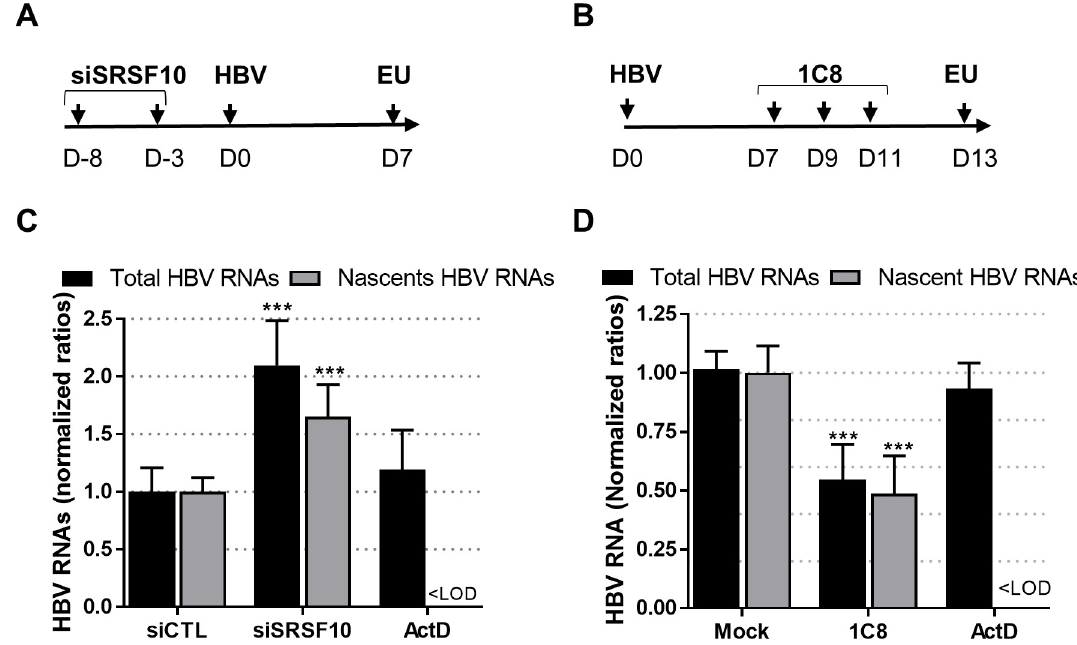
Fig 7. Analysis of nascent HBV RNAs following SRSF10 KD or 1C8 treatment. (A) dHepaRG cells were transfected with siRNA against SRSF10 and then infected with HBV (MOI of 250 vge/cell). Edu labelling was performed at D7pi for 2 hours. (B) dHepaRG cells were infected with HBV and then treated three times with 1C8 (40 μ M) at D7, D9 and D11pi. EU incorporation was performed at D13pi for 2 hours. (C) and (D) Run-on analyses. Intracellular RNA was extracted from transfected/treated cell cells and either directly quantified using HBV primers (Total HBV RNAs) or purified using the Click-iT Nascent RNA Capture kit to quantify newly synthetized RNAs (nascent HBV RNAs). Control was provided by treating cells with Actinomycin D (ActD at 10mg/ml) added to cells 20 min before labeling (see Methods). < LOD: under the limit of